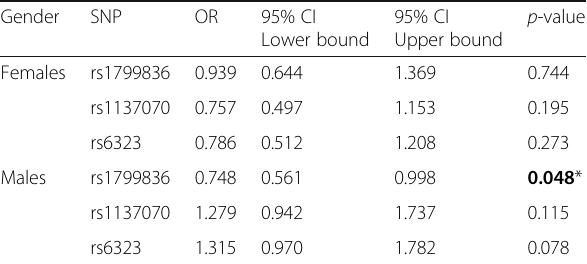
Table 4 Analysis of association between HPRL and the polymorphisms of MAO genes for all patients divided by gender